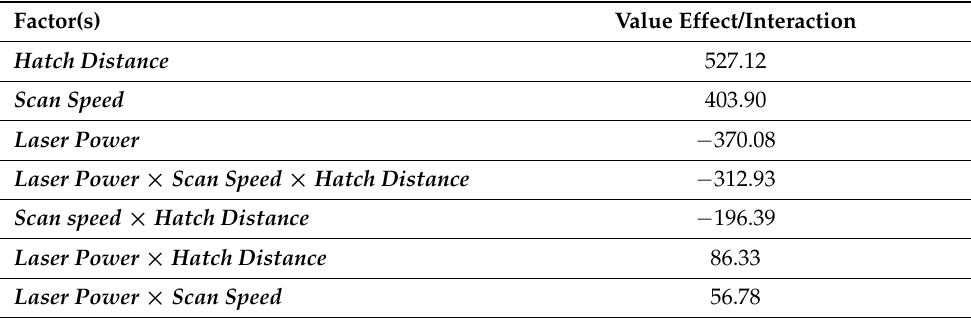
Table 4. Effects and interaction effects of the minimum channel